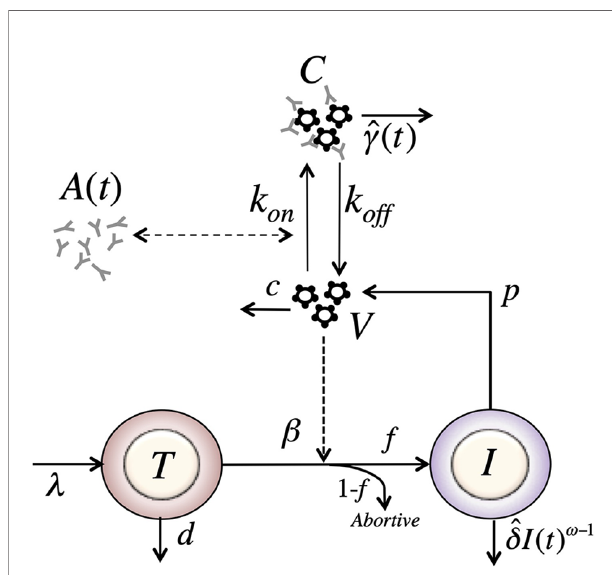
FIGURE 6 | Schematic of the model with reversible binding of Ab to HIV and a time-varying clearance rate of immune complexes. The model include four variables: target cells ( T ), productively infected cells ( I ), free virus ( V ), and VRC01-HIV immune complexes ( C ). Parameters l , d and b s are the production, death and infection rates of target cells; d is the death rate of infected cells; p and c are the production and clearance rates of free virus; k on and k off are the binding and dissociation rate constants of VRC01 to free virus; ^ g ( t ) is the time varying clearance rate of VRC01-HIV immune complexes. The antibody concentration, A ( t ), is determined from the best- fi t of the two-compartmental model to VRC01 concentration measurements for each individual (see